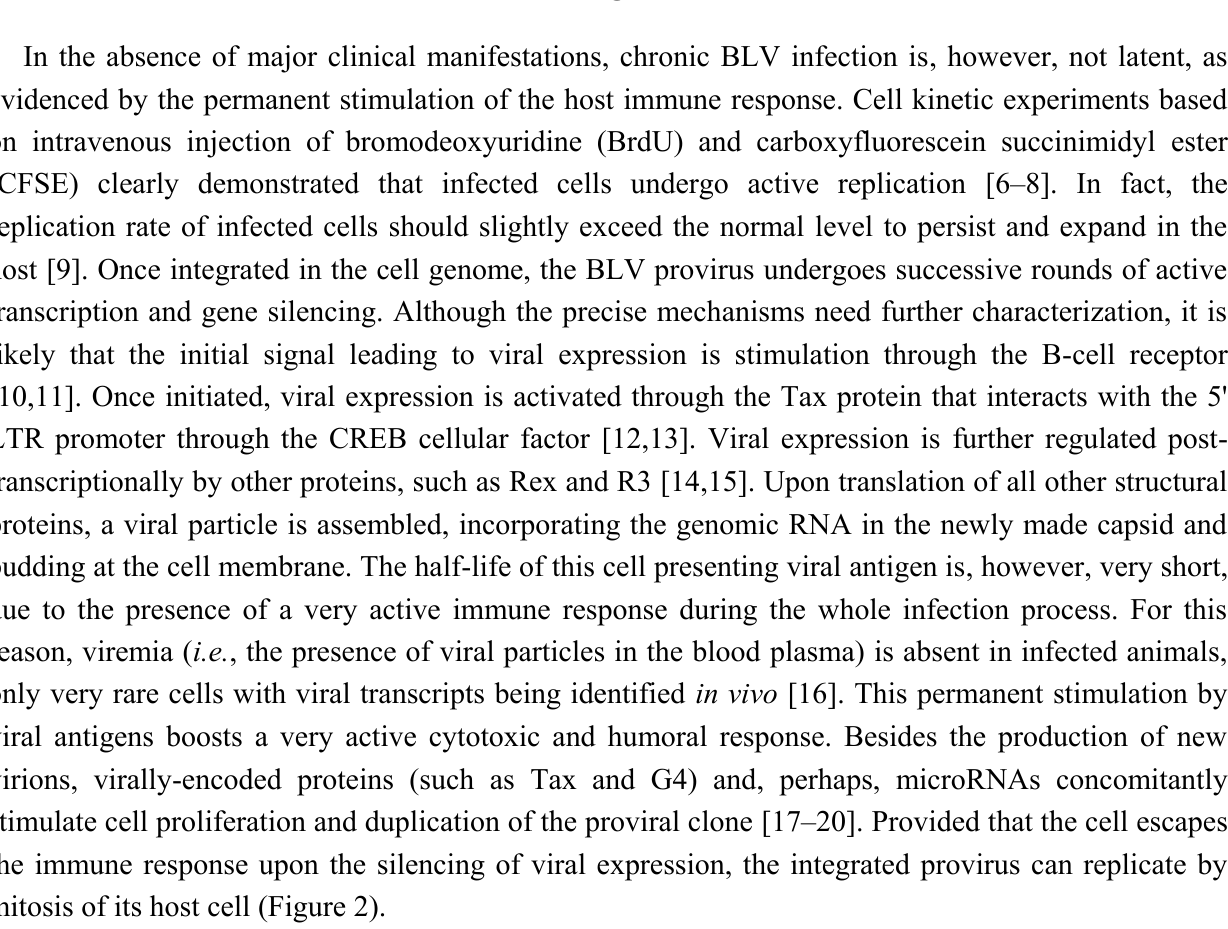
Figure 2. The onset of mutations during BLV infection. During infection, BLV-encoded oncogenes (Tax, G4 and, perhaps, microRNAs) stimulate proviral replication. This clonal expansion faces tight control by the host immune response. Successive replication/destruction cycles lead to the onset of replication errors in the viral and host cell genomes (  ). microRNAs)immune